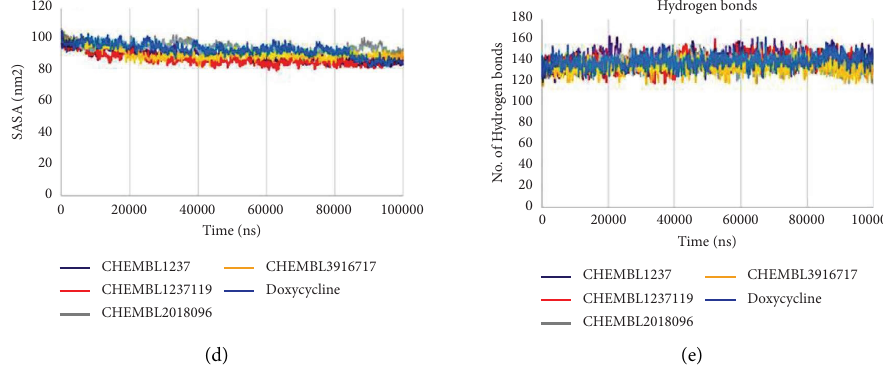
Figure 5: Schematic presentation of simulation plots. Te plots represent features of (a) root mean square deviation (RMSD), (b) root mean square fuctuation (RMSF), (c) radius of gyration (Rg), (d) solvent-accessible surface area (SASA), and (e) hydrogen bonds (H-bonds) at 100nanoseconds of molecular dynamics simulation using the GROMACS software.